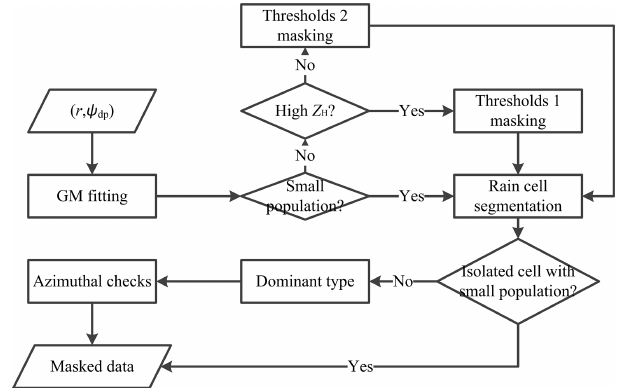
Figure 2. Flowchart of data